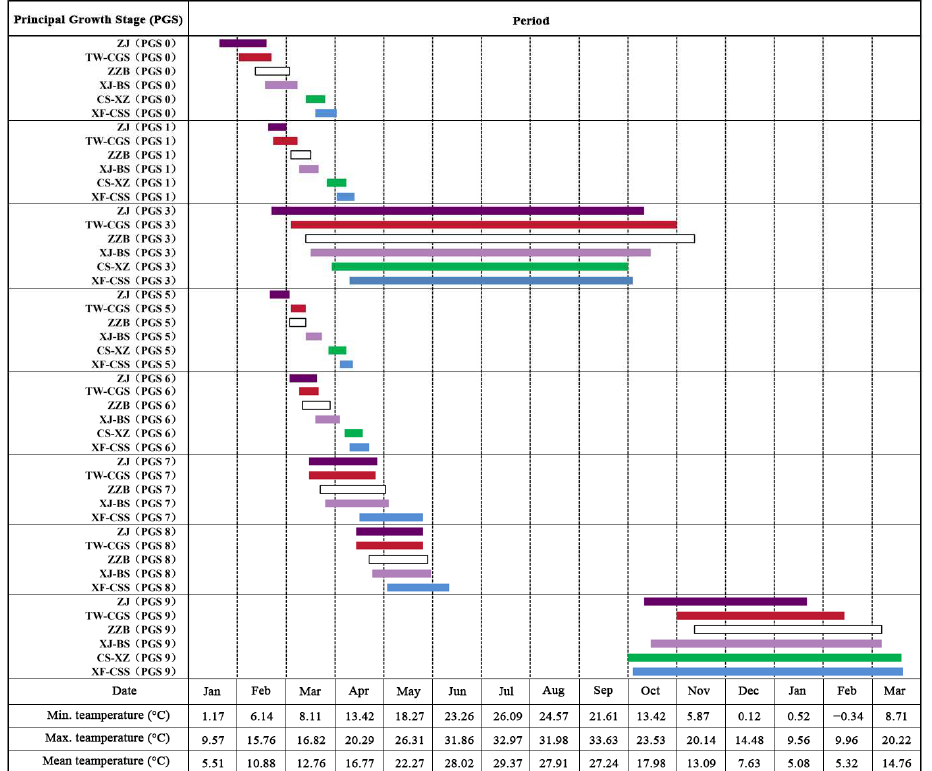
Figure 7. Schematic representation of the growth stages for six mulberries (data gathered from 2021 to 2022). The purple rectangle represents the ‘ZJ’; the red rectangle represents the ‘TW-CGS’; the white rectangle represents the ‘ZZB’; the pink rectangle represents the ‘XJ-BS’; the green rectangle represents the ‘CS-XZ’; the blue rectangle represents the ‘XF-CSS’.